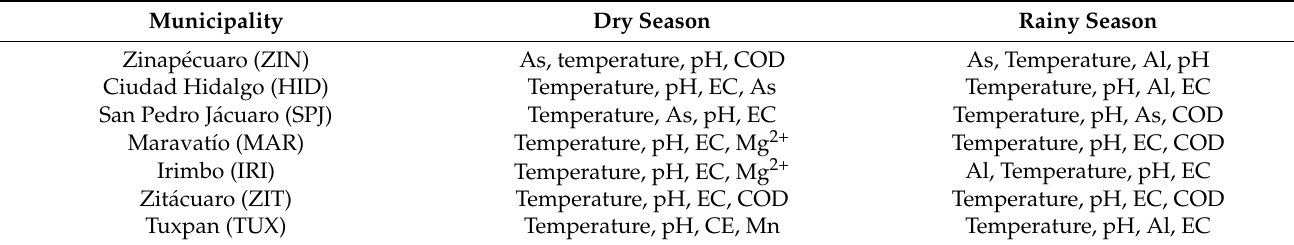
Table 5. Water quality parameters with higher E w i and major influence on